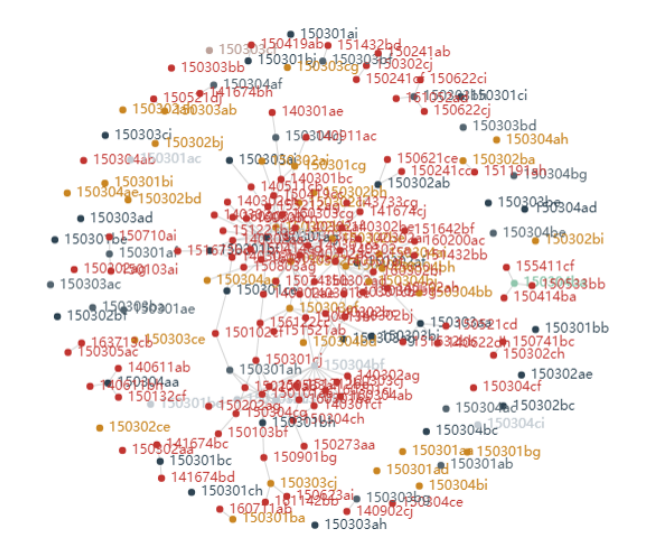
Figure 3. Force-directed layout for relationships among students.